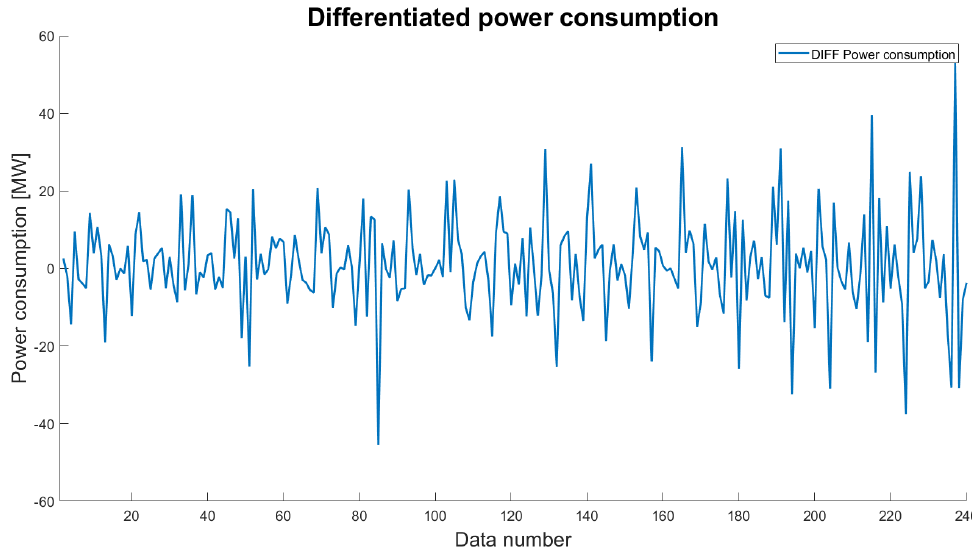
Figure 3. Diff Data for Monthly power consumption in Quito, Ecuador between January 1999 and December